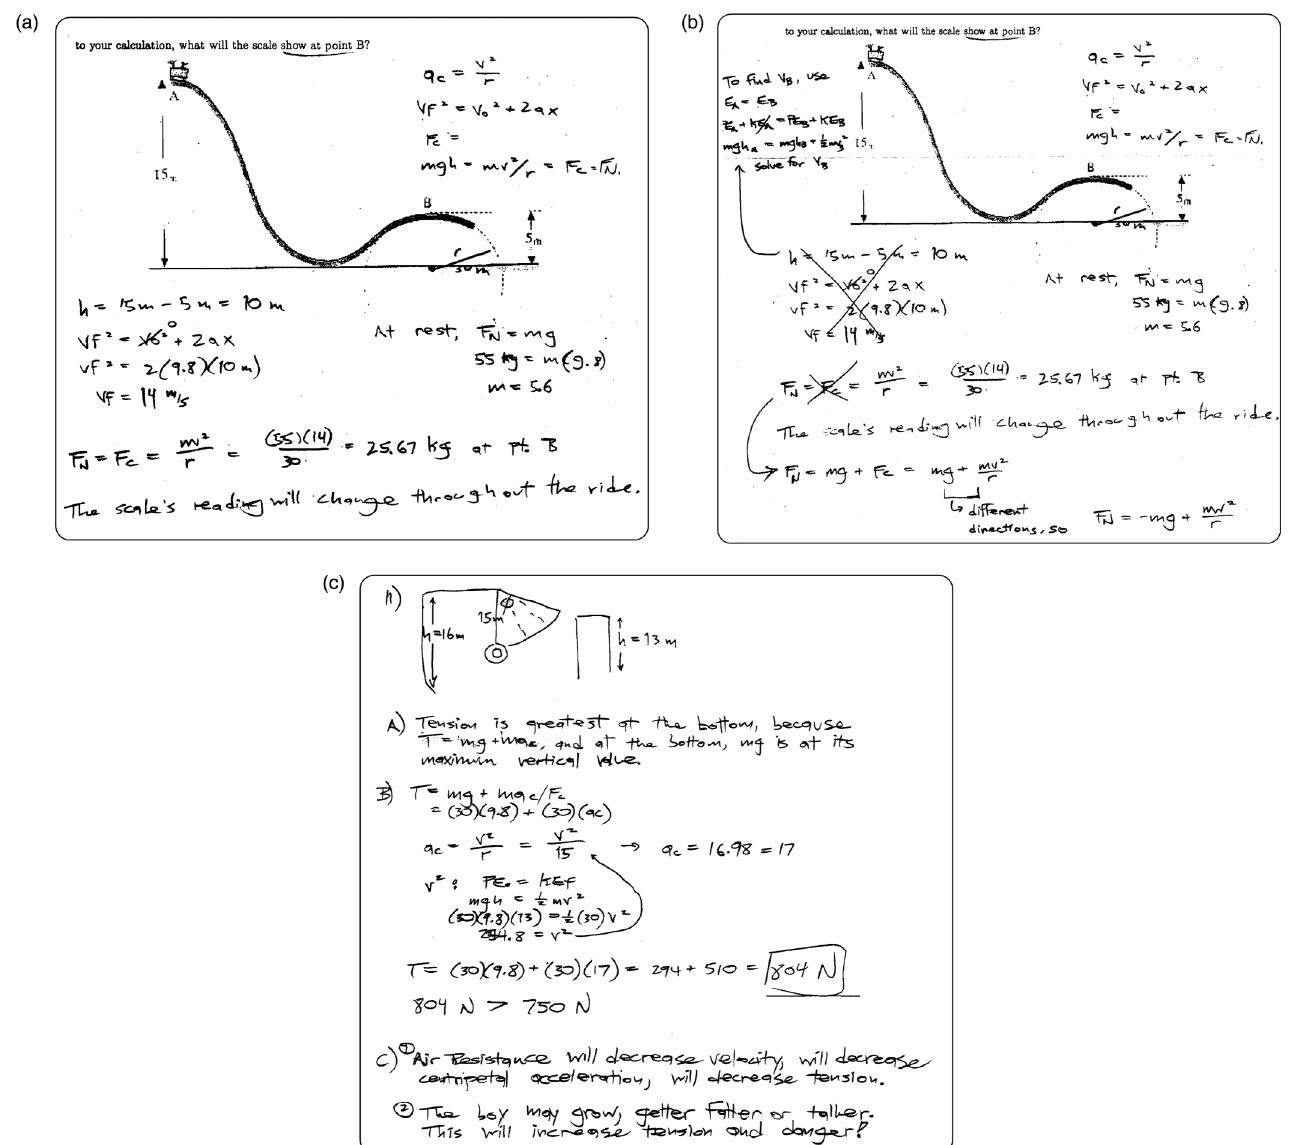
FIG. 10. (a) Pre problem attempt by another student from group C. Mistakes: (1) kinematics are used instead of energy conservation, ¼ mg . (b) Self-diagnosis attempt by the is equated to F , (3) the target variable is identified as a new mass yielded from F (2) F N C N same student. References to mistakes cited in (a) are (1) refers to the problem in invoking EC, ‘‘To find vb, use E A ¼ E B ,’’ and shows how to use EC, (2) corrects the incorrect application of Newton’s 2nd law and writes the correct description of the law, (3) identifies the as the correct one. Note that the previous error of finding a new mass is not erased. (c) This incorrect target variable and isolates F N student’s attempt on the midterm (post) problem. The wrong height is used in addressing the potential energy of the system, but there is an improvement relative to the errors described in (a), as follows: (1) energy conservation is used correctly, (2) Newton’s 2nd law is addressed more properly, and (3) the target variable is properly identified. Here, the force of tension on the rope is analogous to the normal force in the quiz